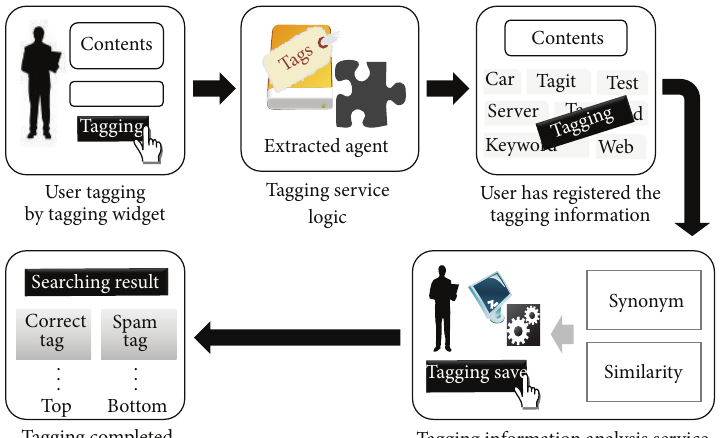
Figure 4: System flowchart.